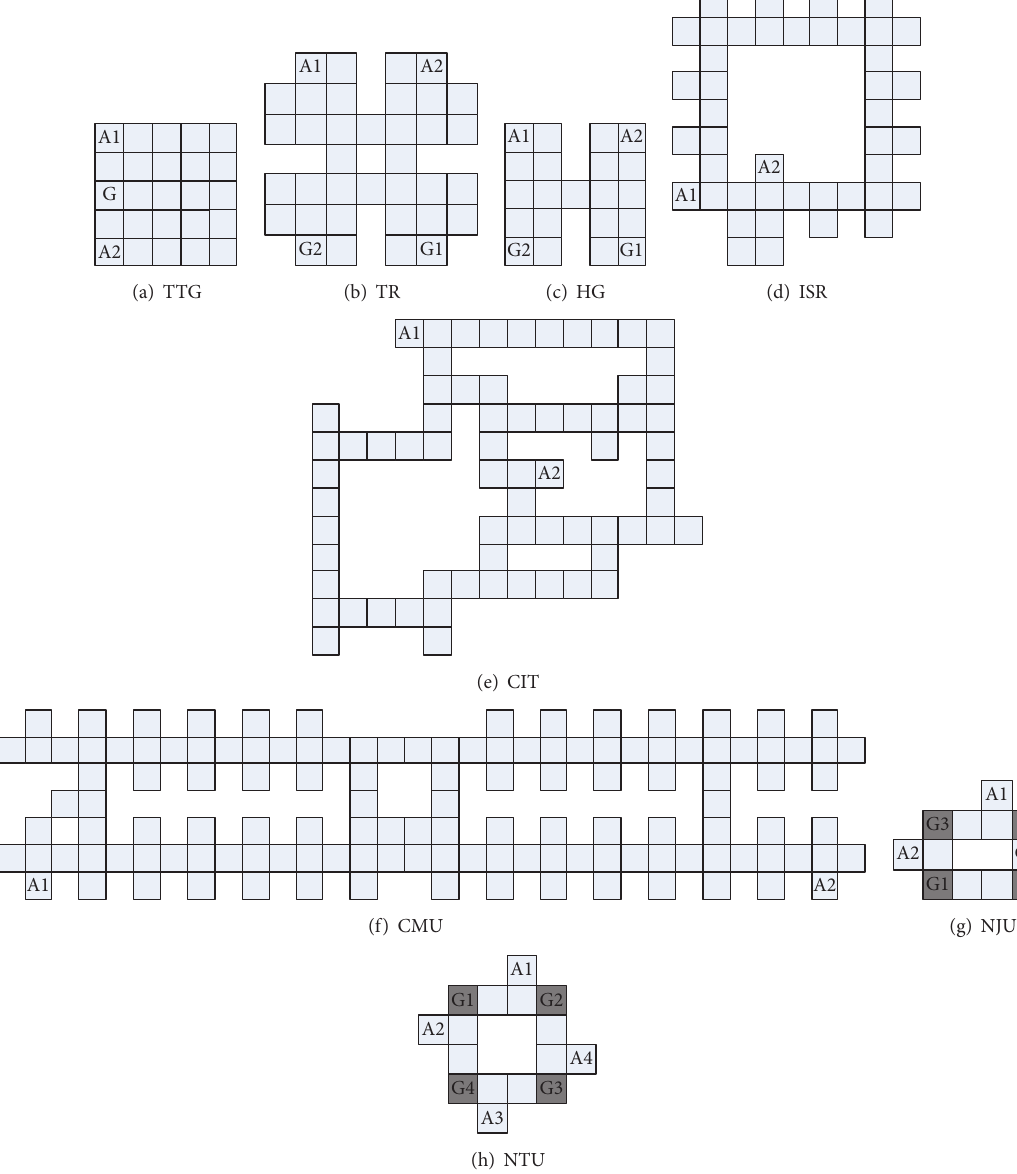
Figure 2: Different multiagent grid-world games used throughout this